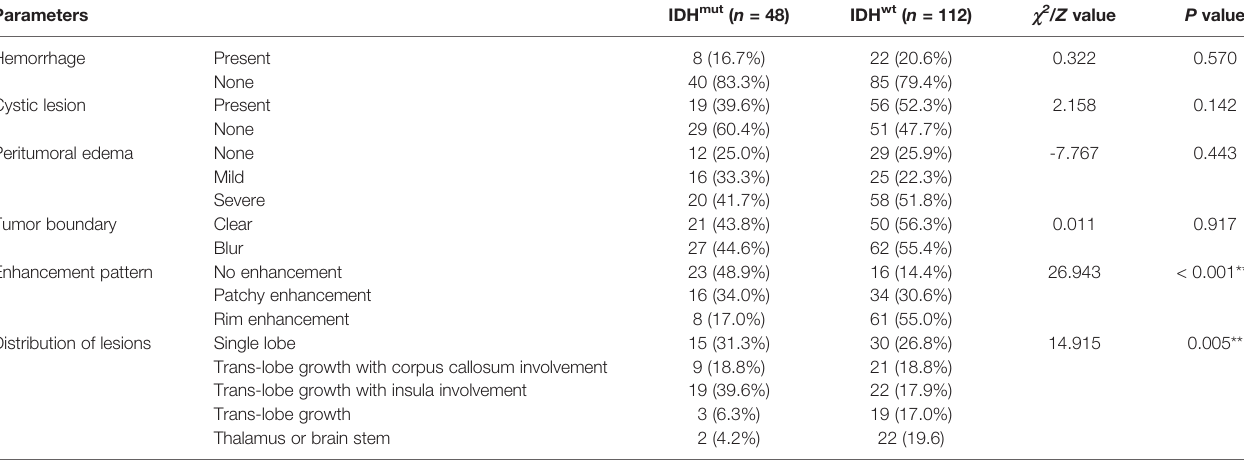
TABLE 3 | Comparison of MRI morphological characteristics between IDH-mutant and IDH-wild type gliomas. Parameters Hemorrhage